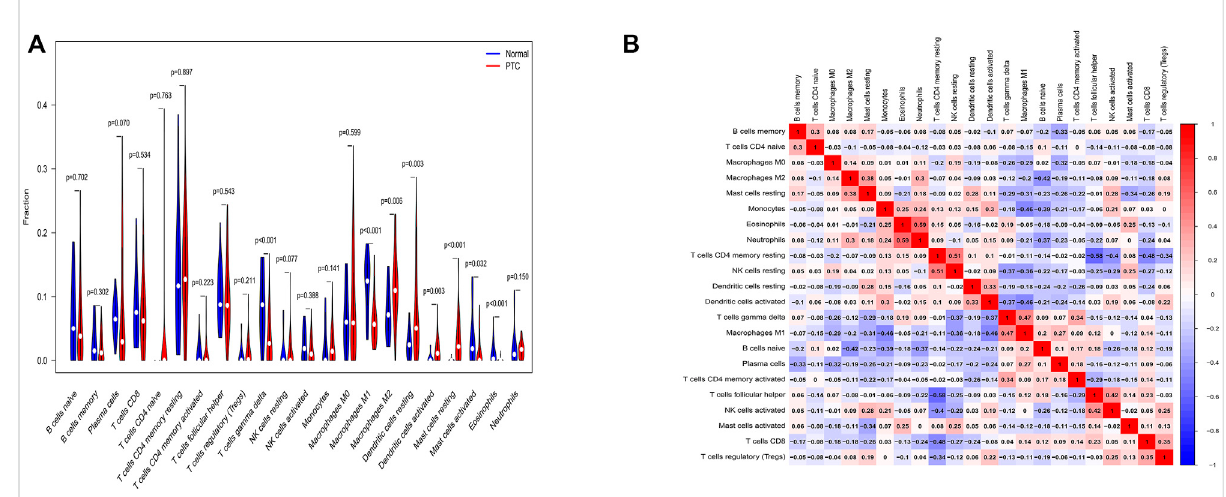
FIGURE 4 The results of immune cell in fi ltration analysis. (A) The distribution of immune cells between normal samples and PTC samples. The abscissa shows various immune cells, and the ordinate shows fraction. p < 0.05 was regarded as statistically signi fi cant. (B) Correlation analysis of immune cells.Theabscissaandordinateareonbehalfofimmunecells,andthenumberstandsforcorrelation.Redcolorrepresentsapositivecorrelation,and blue color represents a negative correlation. The larger absolute value or deeper color explains the higher